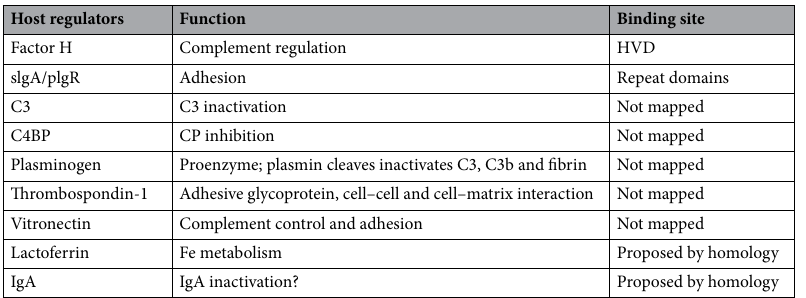
Table 1. Host regulators binding to S. pneumoniae PspC and Hic proteins. The domains are listed in order of their location starting from the N-terminus. Known domains and new domains are included. The table includes domains which are found in both PspC and Hic variants, domains which are specific for either PspC or Hic, and those which are found in other bacterial proteins. SP signal peptide, HVD hypervariable Domain, RD Repeat Domain, RCD random coil domain, S n D/GS 2 Serine Rich segment, RCE random coil extension, R-type repeat related Domain; EPRD extracellular proline rich domain, VS variant specific, IgA IgA binding domain, PRD proline-rich domain, CBP choline-binding